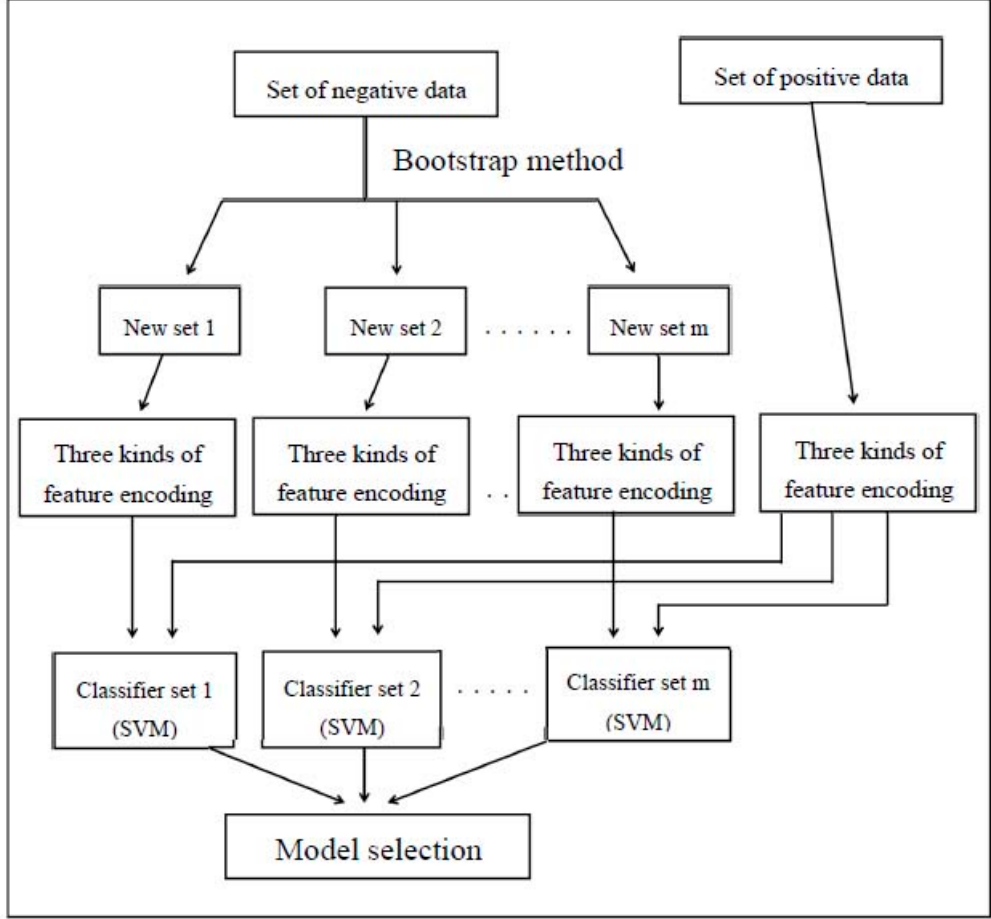
Figure 1. The flowchart of classifier evaluation. SVM: support vector machine.